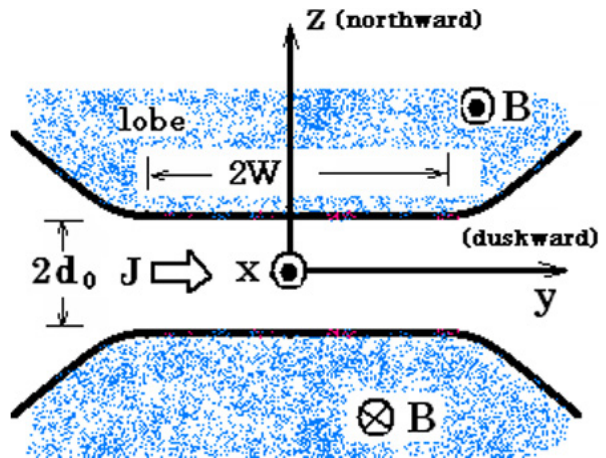
Fig. 1. Schematic drawing of the tail current sheet in the (y,z)-plane, where the x-, y- and z-axes, employed in the present study, are directed to the Earthward, duskward and northward directions, re- spectively, consistent with the conventional GSM coordinates; also, J is the sheet current, and 2 W and 2 d 0 indicate the effective current sheet width and thickness,